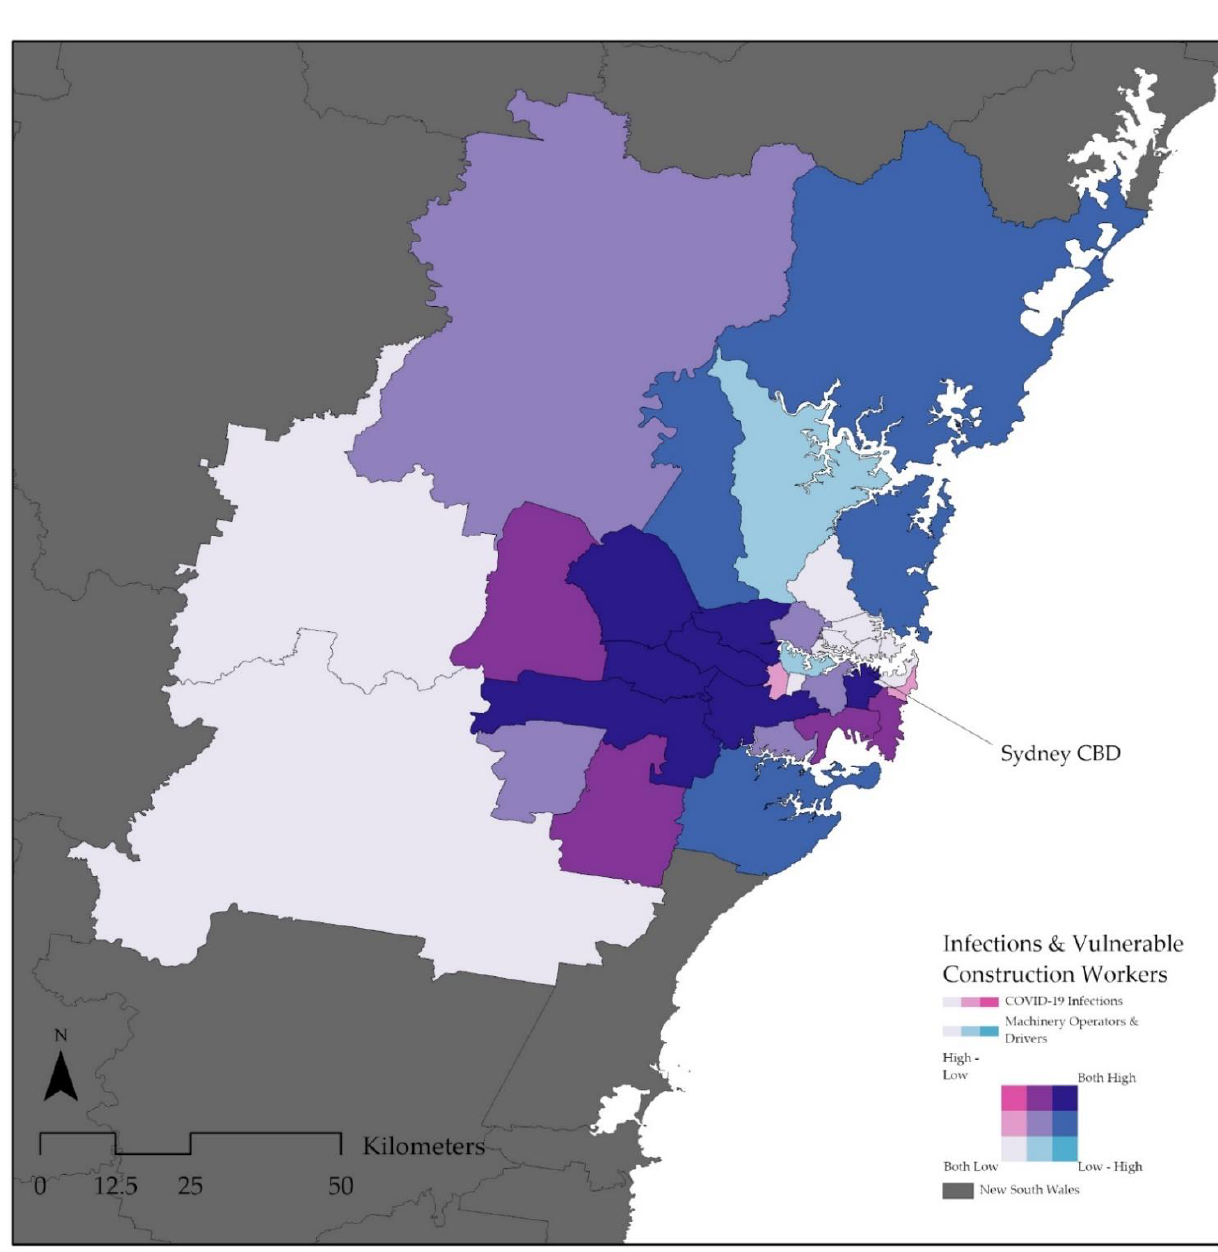
Figure 5. Bivariate choropleth map showing Sydney LGAs with a high number of COVID-19 cases and a high number of Machinery Operators and and a high number of Machinery Operators and Drivers.